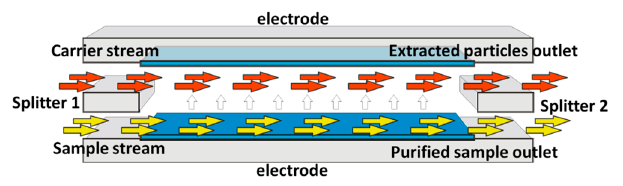
Figure 1. SPLITT system scheme. The splitters play a key role to maintain the “splitting plane”.